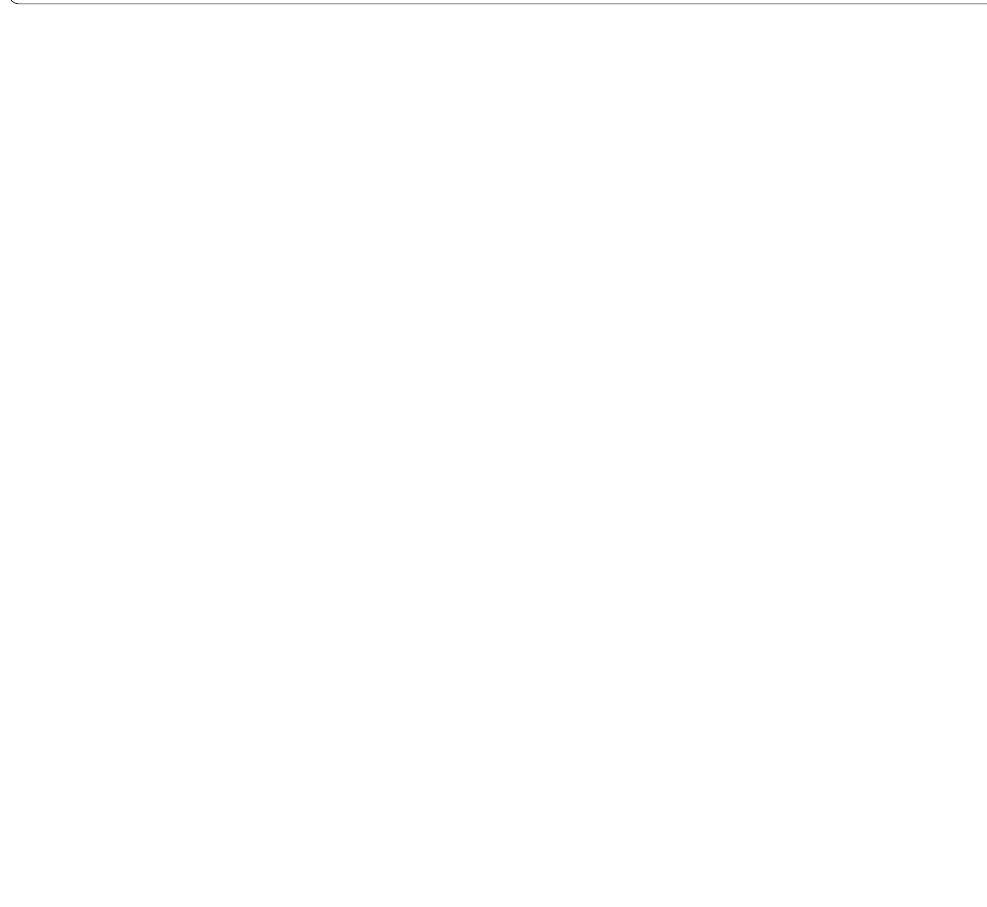
(See figure on next page.) Figure 13 Shaft orbit and the spectrum of rotor system with a slant crack based on fractional damping (under the different crack